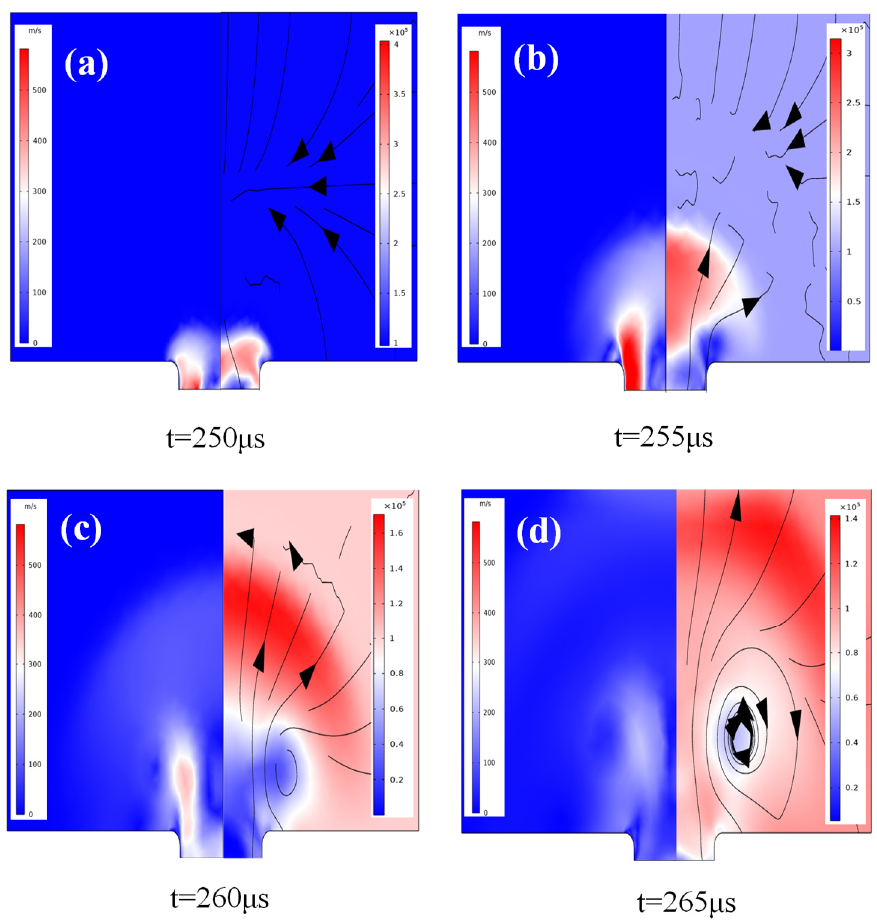
Figure 6. Velocity and pressure fields of plasma and absorbing waves (velocity field on the left and pressure field on the right ): ( a ) t = 250 μ s; ( b ) t = 255 μ s; ( c ) t = 260 μ s; ( d ) t = 265 μ s.